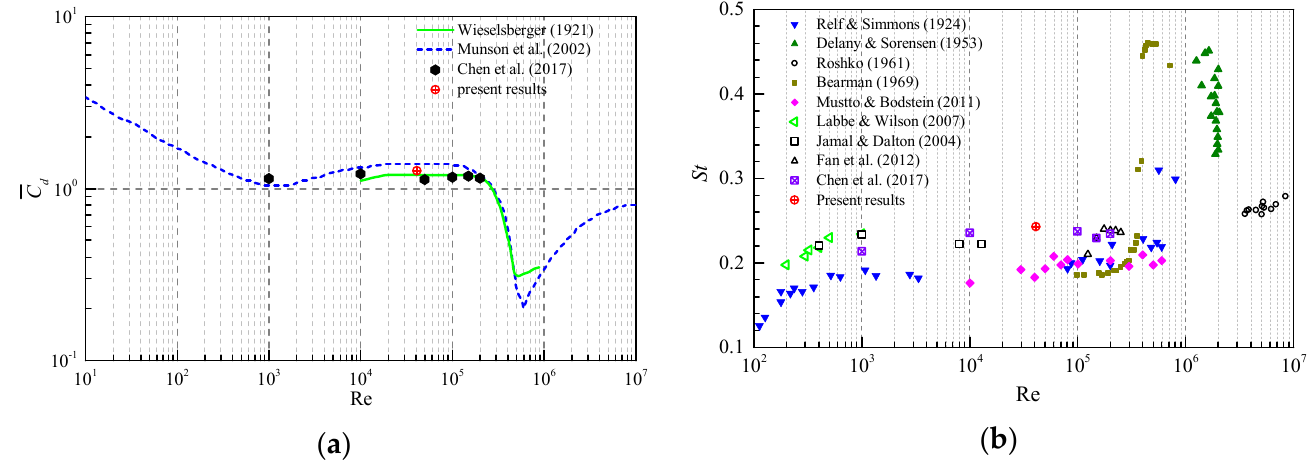
Figure 3. Comparisons of aerodynamic coefficient and the Strouhal number with previous results.